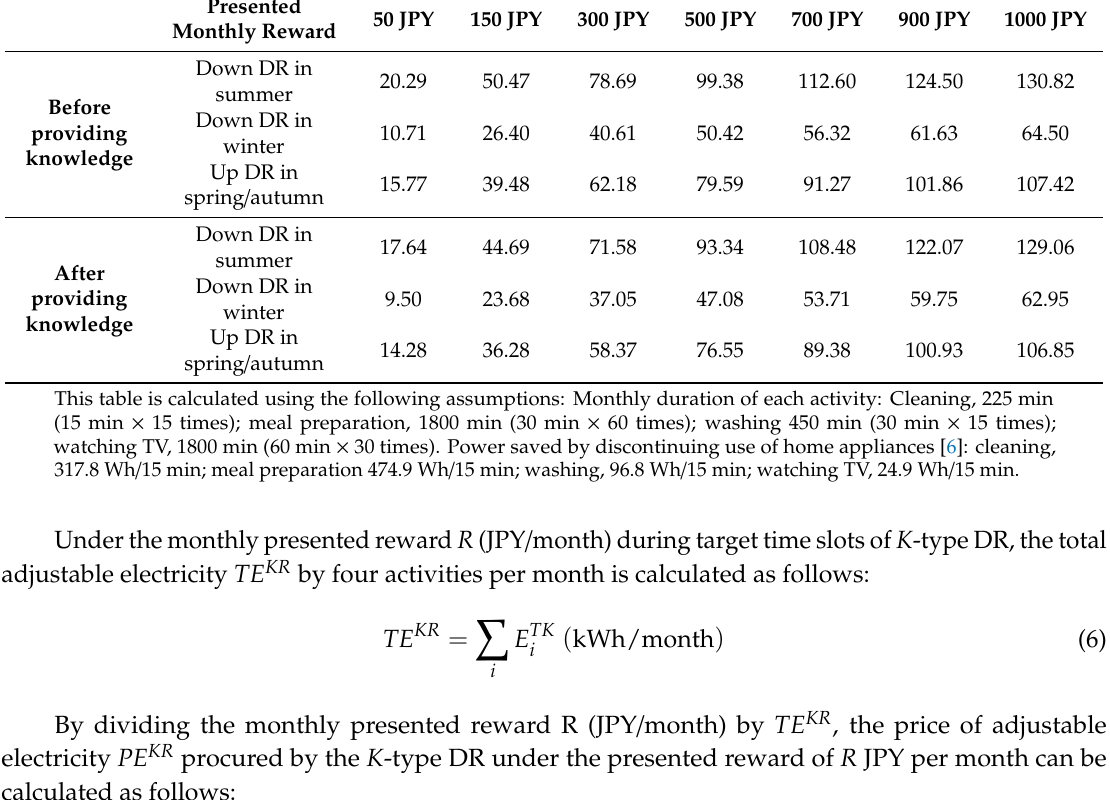
Table 3. Relationship between presented monthly reward and electricity price of adjusting power (Unit: JPY / kWh).